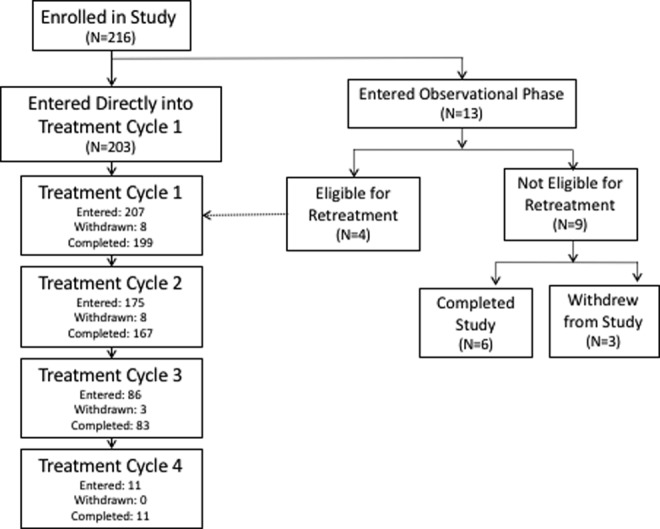
Patient disposition.